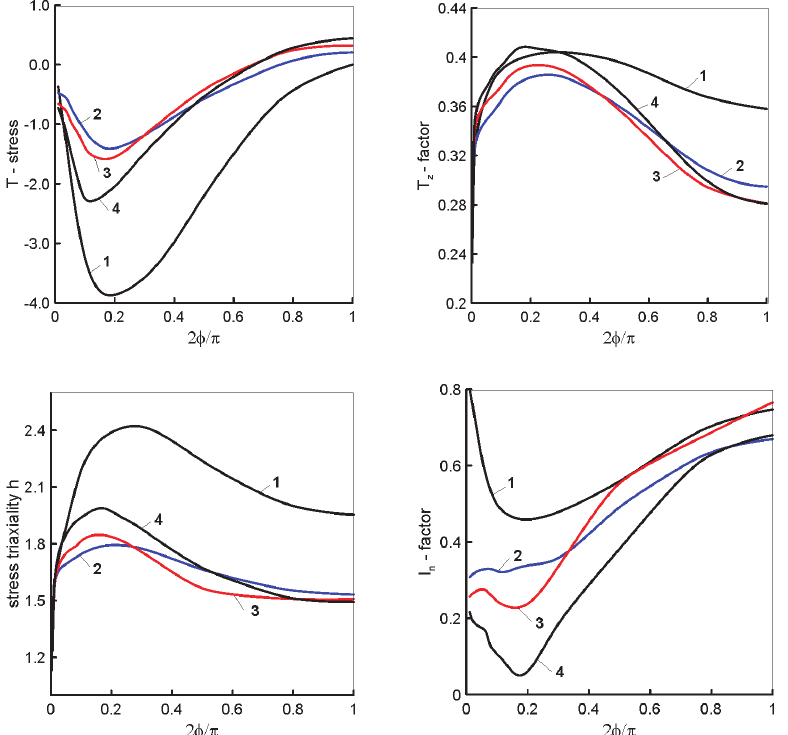
Figure 5: Constraint parameter distributions for bending plate along crack front (1-initial, 2-3-intermediate, 4-final).